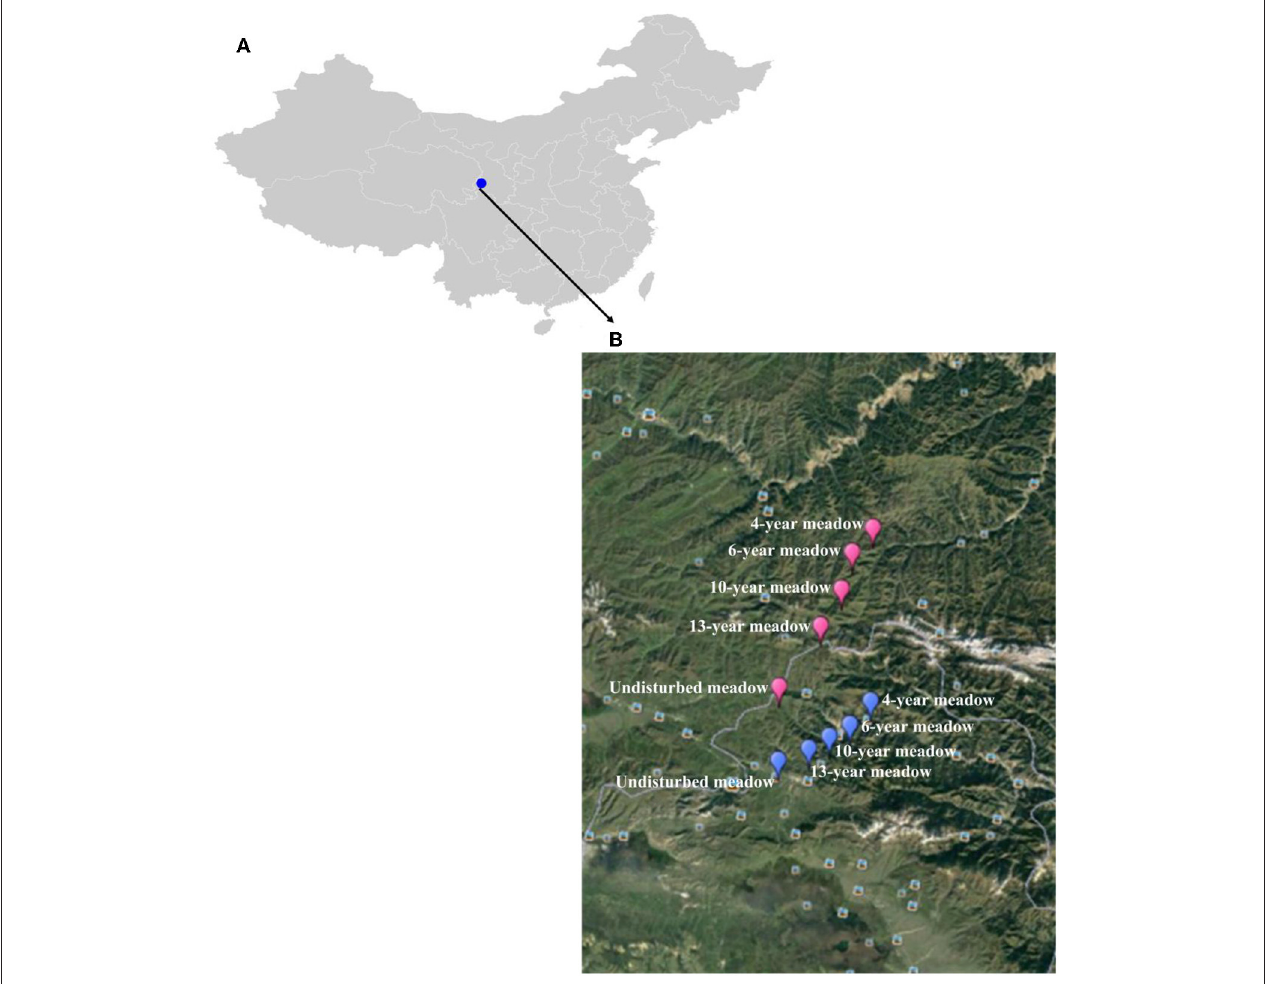
FIGURE 2 | Location map of study sites in the eastern part of the Qinghai Tibetan plateau, Hezuo, China. (A) Hezuo city (B) locations of ten sites representing each of the five successional ages (4-, 6-, 10-, 13-year and natural grassland).